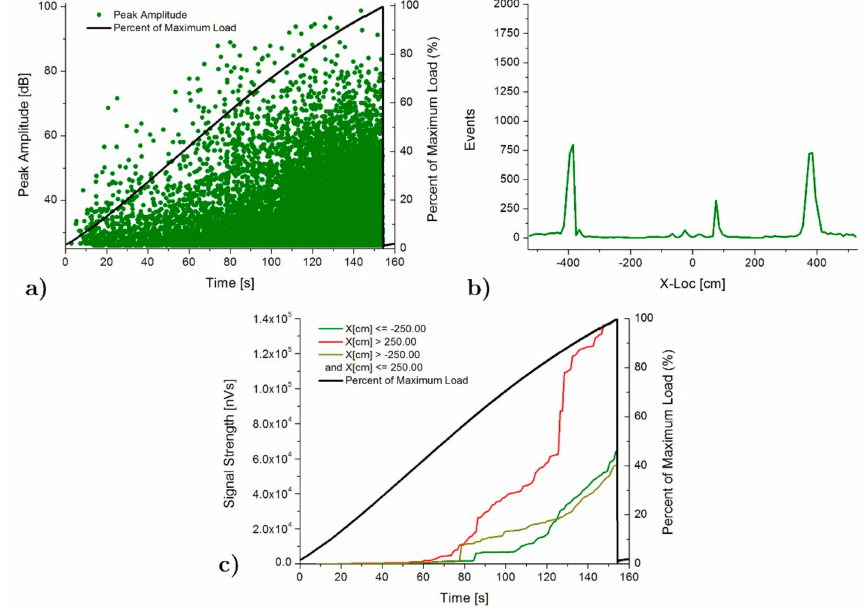
Figure 12. AE results for SLC specimen: ( a ) Peak amplitude vs load history over the time, ( b ) Linear location over the specimen and ( c ) Signal strength vs load history over the